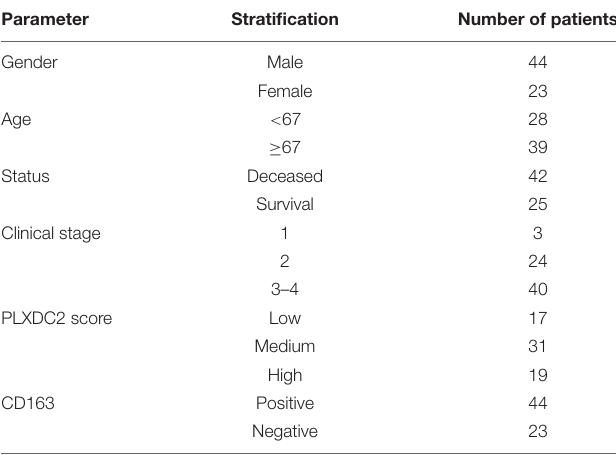
TABLE 1 | Patients’